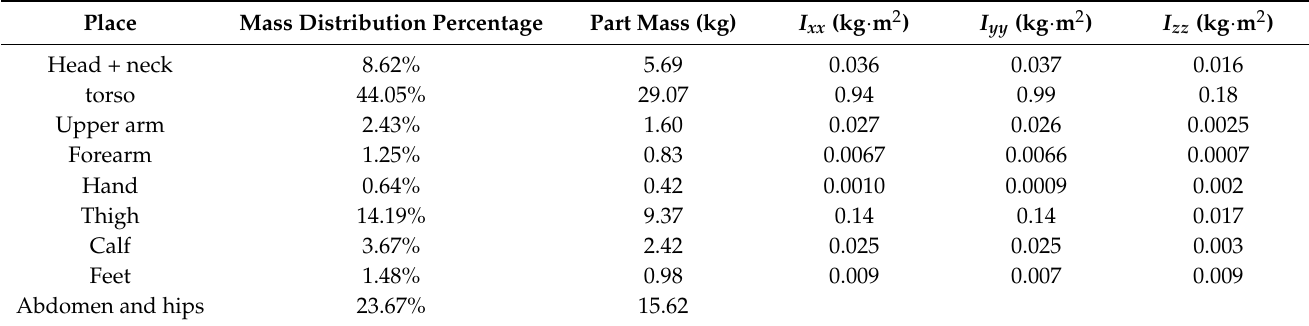
Table 1. Ratio of mass distribution and moment of inertia of various parts of the human body.